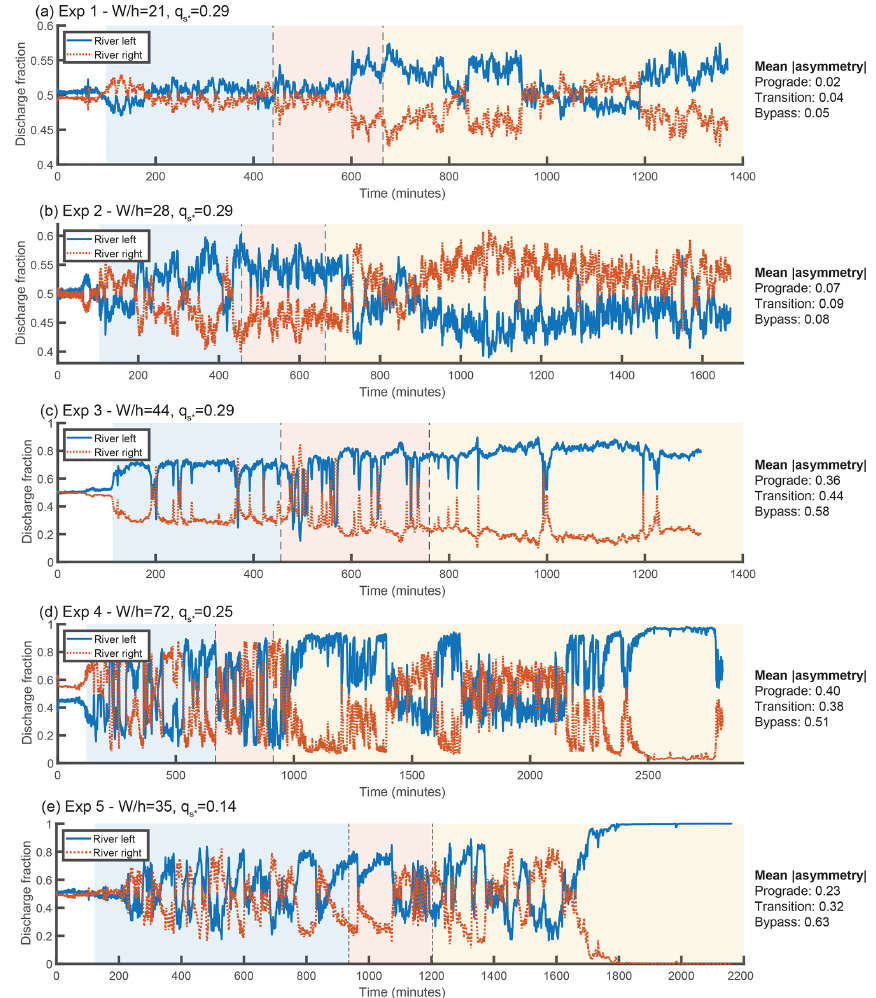
Figure 5. Time series of the water discharge fraction exiting each branch. Background colors represent the progradational, transitional, and bypass phases of each experiment. Mean values of the absolute value of the asymmetry ( | (cid:49)Q | ) of each phase are provided to the right of each time series. Note that | (cid:49)Q | is equivalent to the difference between the larger discharge fraction and smaller discharge